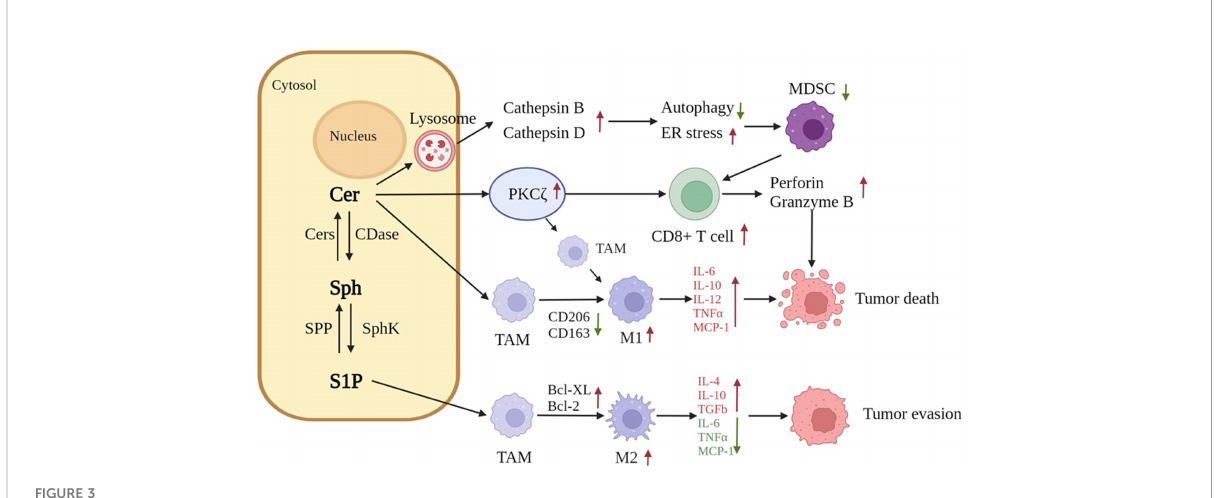
FIGURE 3 In fl uence of sphingolipids on the tumor